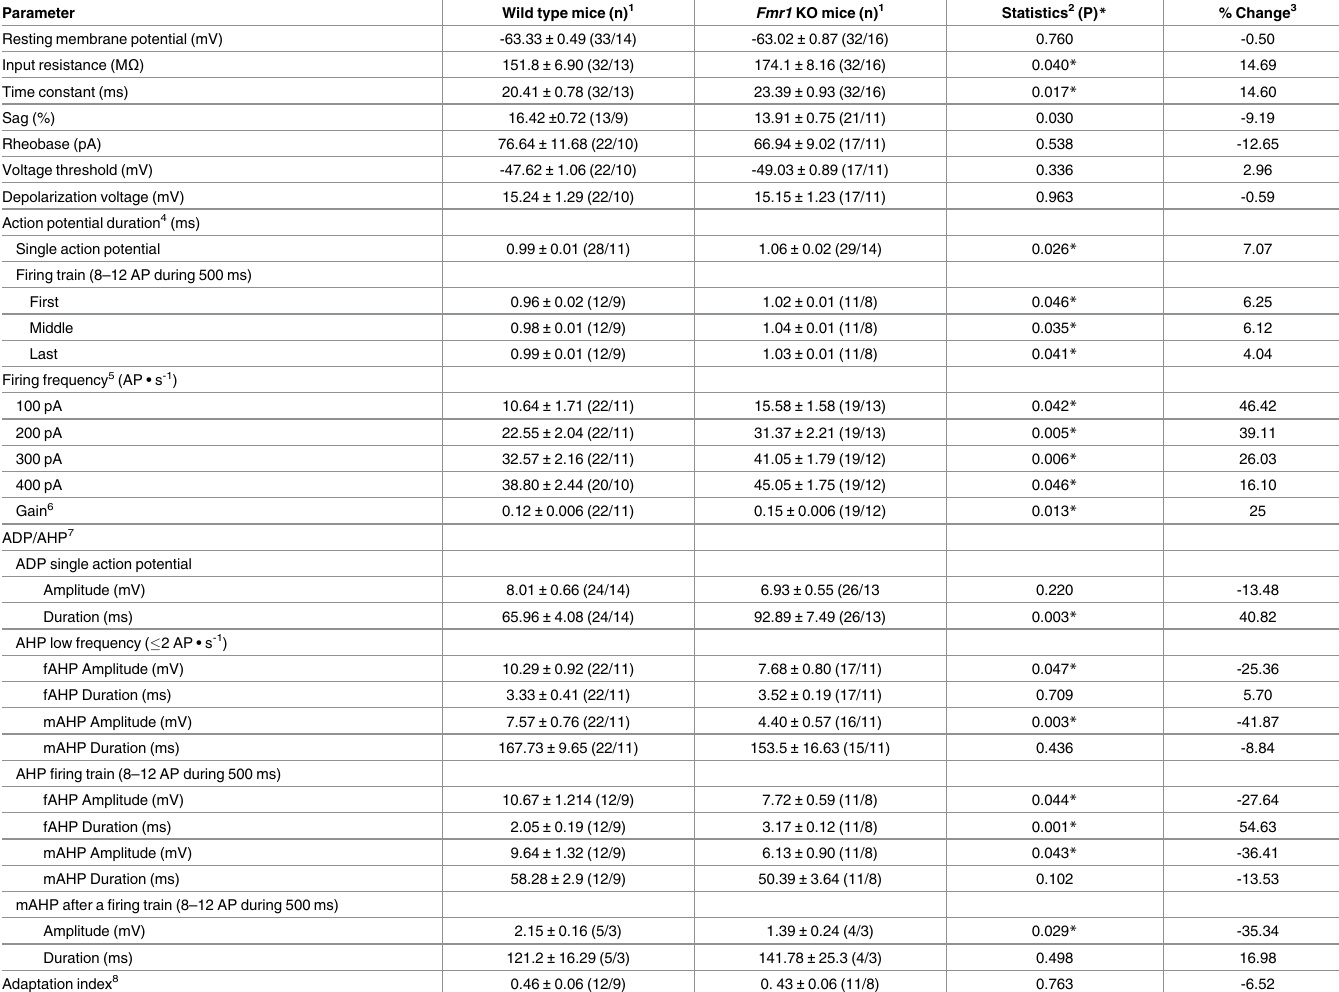
Table 1. Membrane properties of the CA1 pyramidal cells in wild type and Fmr1 KO